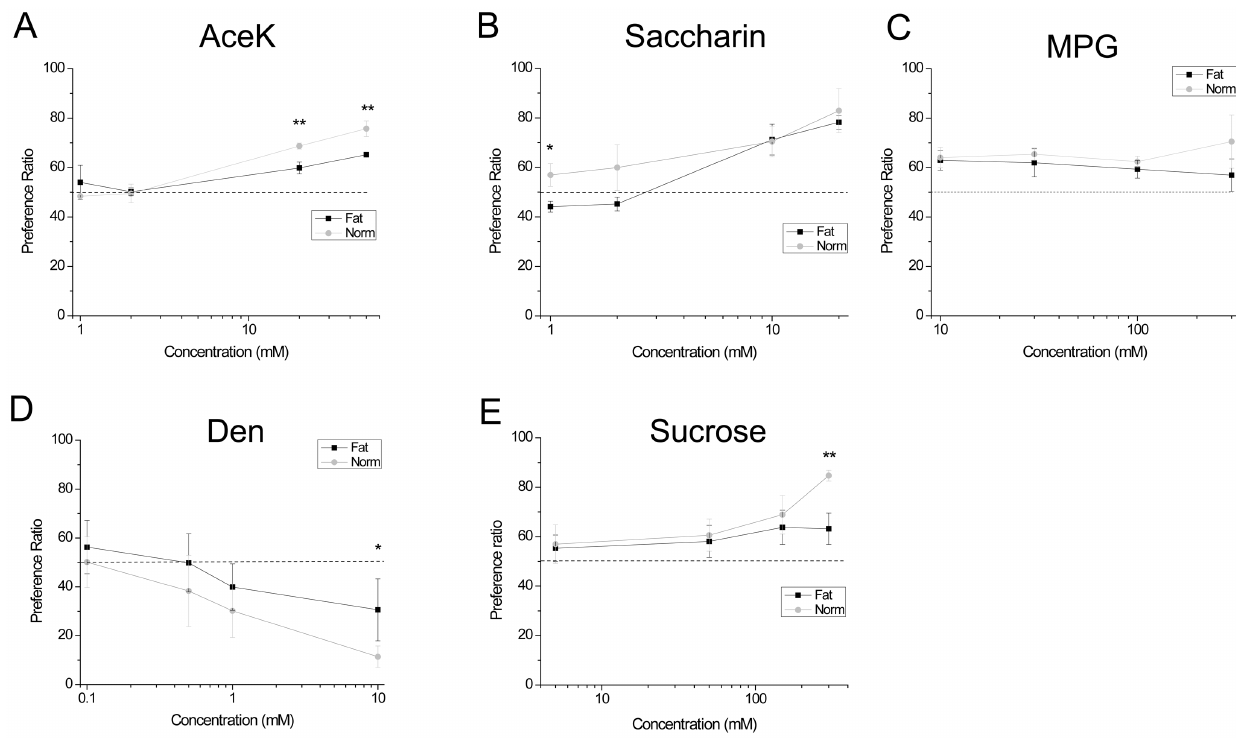
Figure 5. Preference ratios for taste stimuli are altered in obese mice. (A) For the sweet stimulus AceK, the ability to detect this sweetener at higher concentrations was impaired in obese mice compared to controls (**, p , 0.01). (B) For saccharin, obese mice were significantly impaired in their ability to detect this sweet stimulus at the lower concentrations tested (*, p , 0.05) but were not significantly different in their preferences from controls at higher saccharin concentrations. (C) Control mice showed an increased preference for the umami stimulus, MPG, at the highest concentration but no significant differences between normal and obese mice were measured (p=0.056). (D) The ability to avoid denatonium at the highest concentration was compromised in obese mice (*, p , 0.05) compared to littermate controls. (E) Obese mice were comparable to wild type control mice in their preference for sucrose except for the highest concentration of sucrose tested (300 mM). At this concentration, control mice had a very strong significantly higher preference for sucrose compared to the obese